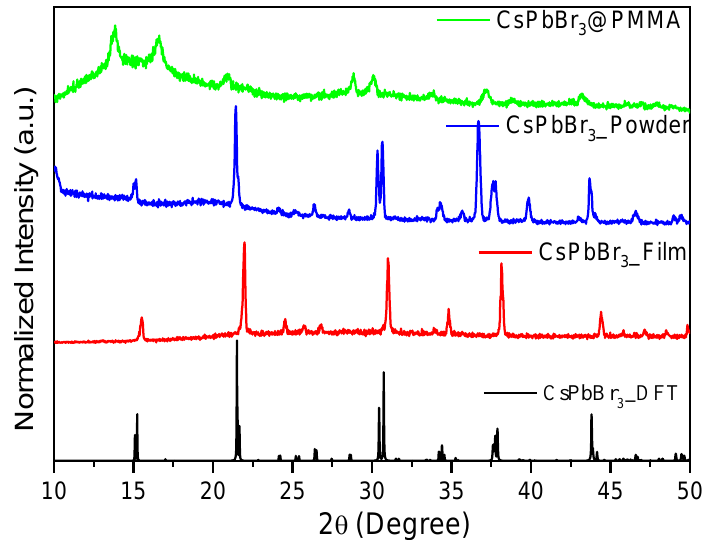
Figure 1. X-ray diffraction (XRD) patterns of a CsPbBr 3 perovskite thin disk, as-ground CsPbBr 3 , thin